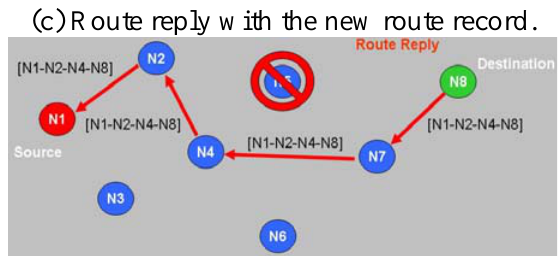
Figure 4. Cont. (c) Route reply with the new route record.